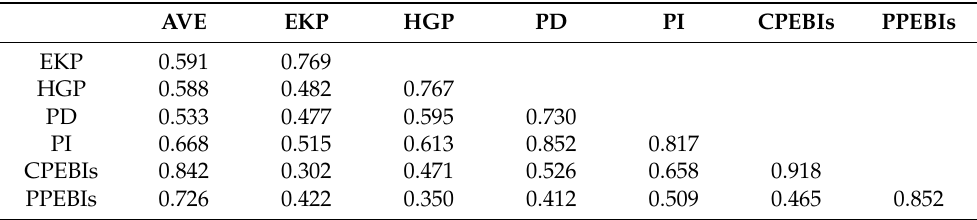
Table 6. Differentiation validity